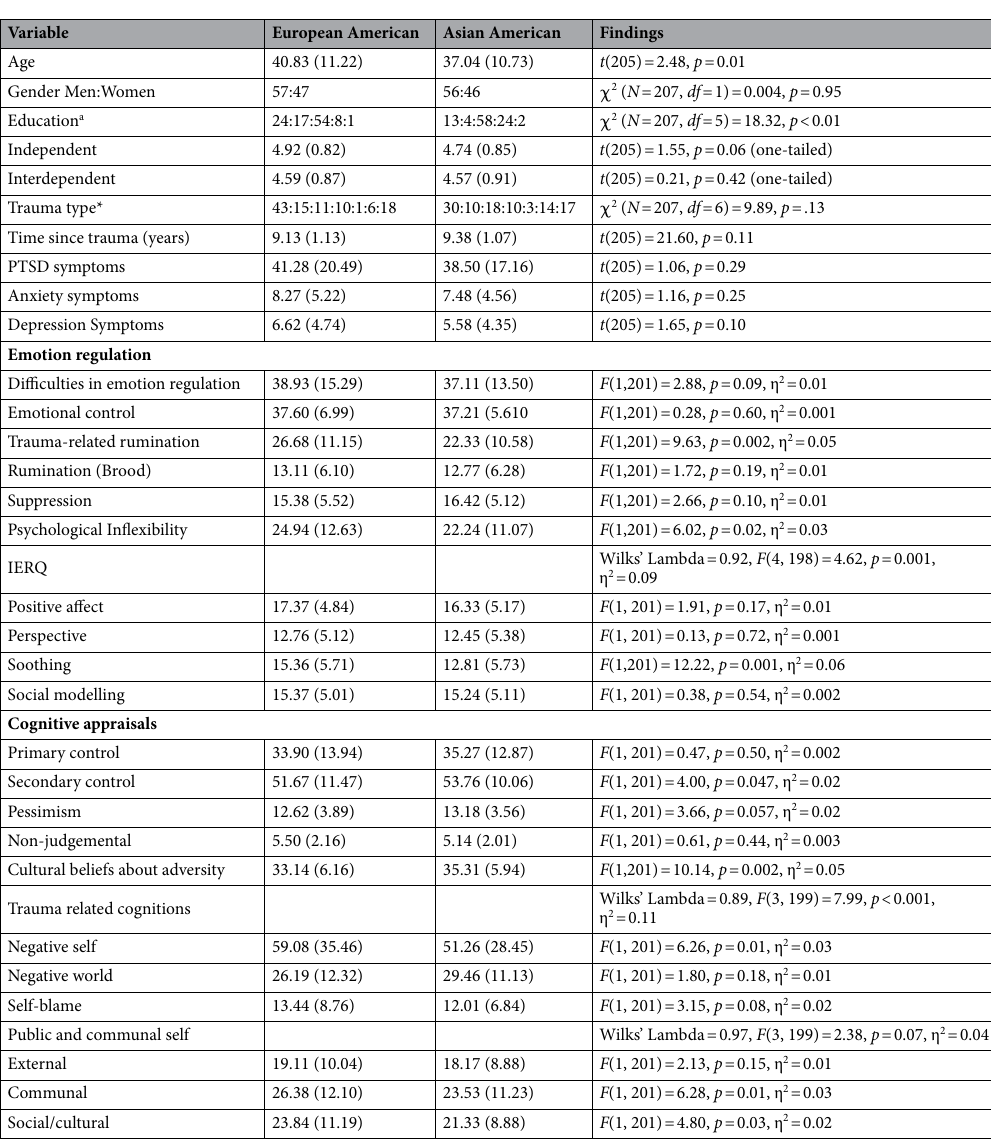
Table 2. Sample characteristics and group differences. * Accident: Natural Disaster: Non-sexual Assault: Sexual Assault: War/Kidnapping: Life-threatening Illness: Unexpected Death. a Secondary: Post-Secondary: Undergraduate degree: Post-Graduate Degree: Prefer not to